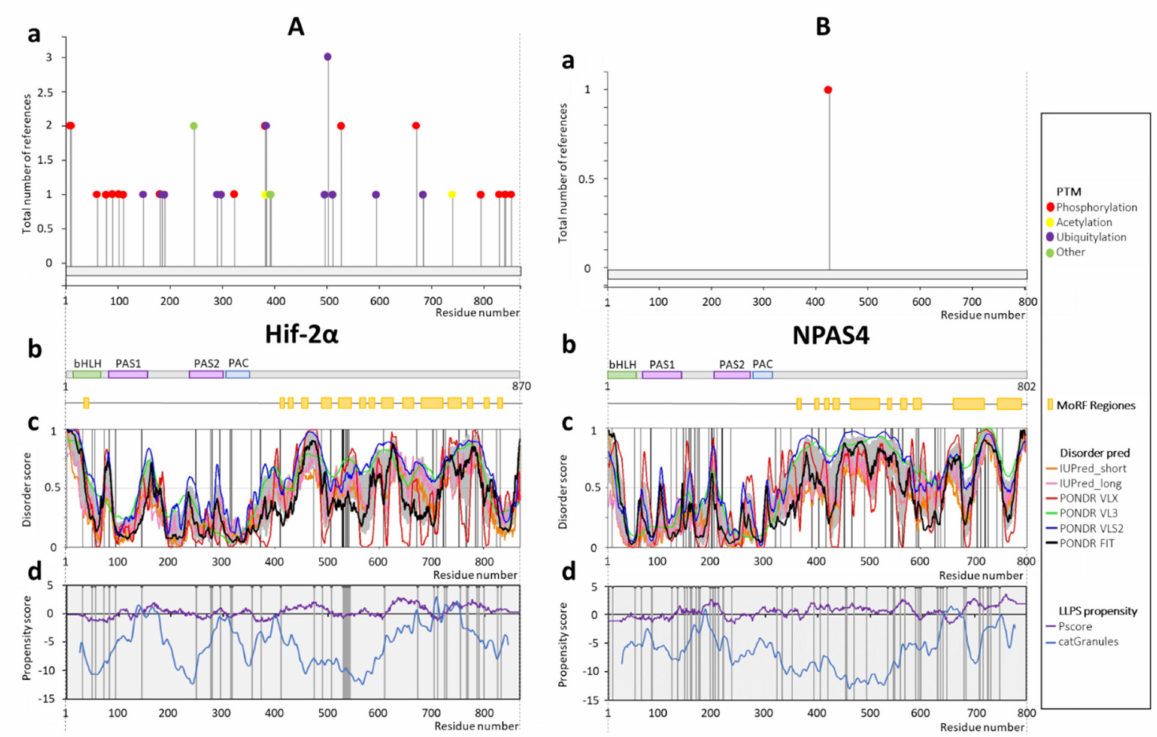
Figure 4. Schematic presentation of results for ( A ) Hif-2 α (Q99814) and ( B ) NPAS4 (Q8IUM7) analysis. ( a ) Post- translational modifications based on PhosphoSitePlus server [99]; ( b ) the domain structure of protein, green indicates the bHLH domain (14–47aa Hif-2 α ; 1–53aa NPAS4), purple represents PAS domains (84–154aa PAS1, 230–300aa PAS2 Hif-2 α ; 70–144aa PAS1, 203–273aa PAS2 NPAS4), whereas blue indicates PAC (304–347aa PAC Hif-2 α ; 278–317aa PAC NPAS4). Predicted MoRFs [100] are indicated as orange rectangles, ( c ) D 2 P 2 database disorder regions predictions based on the protein amino acids sequence (find the legend in the plot for description). Grey shadow presents the averaged disorder profile, and a score over 0.5 indicates a high probability of disorder. Positions of disease-linked mutations are marked as black vertical lines (listed in HuVarBase database [101], Supplementary Materials), ( d ) LLPS propensity predictions based on catGranules (blue line) [102] and PScore (purple line) [103] servers; positions of disease-linked mutations are marked as black vertical lines (listed in HuVarBase database [101], Supplementary